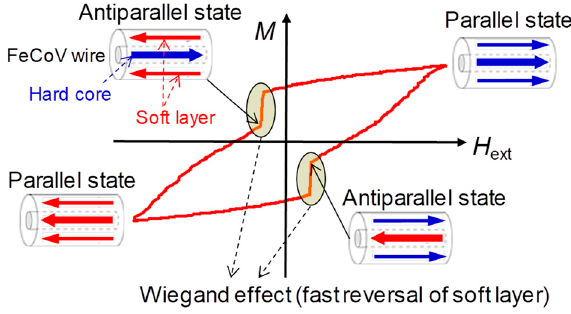
Figure 1. Schematics of magnetization curve and magnetization states of the Wiegand wire.